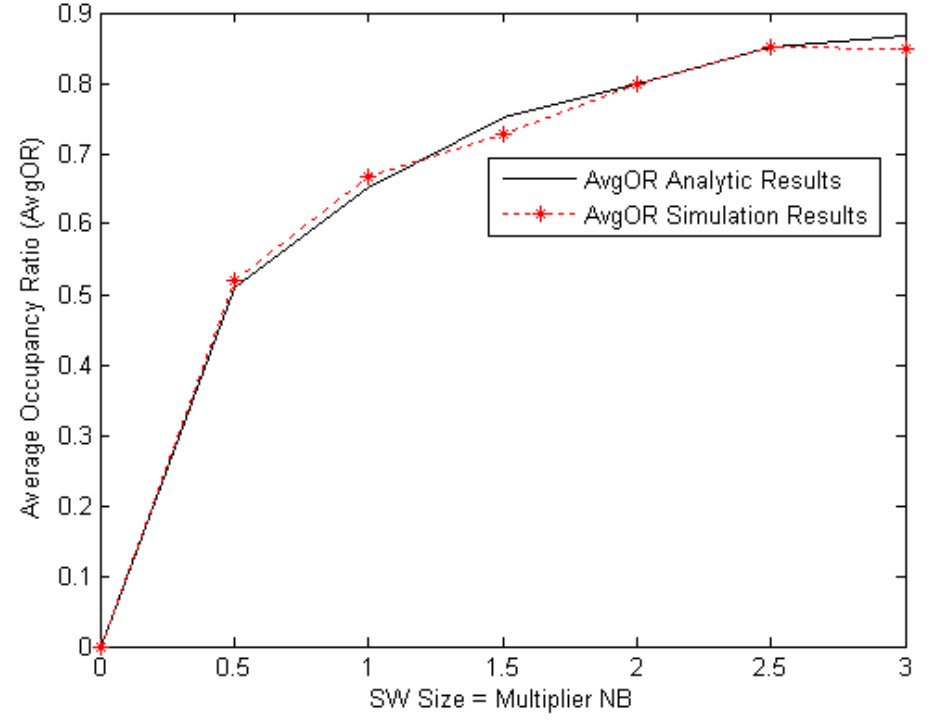
Figure 4. Impact of the SW size on the occupancy possibilities and on the HOP.